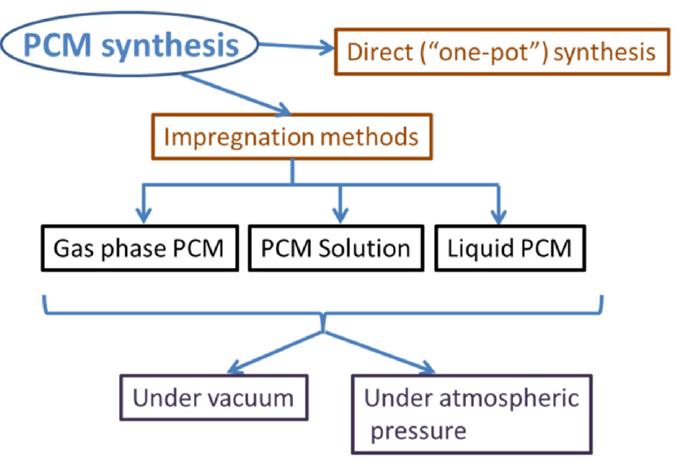
Figure 3. Classification of PCM synthesis methods.